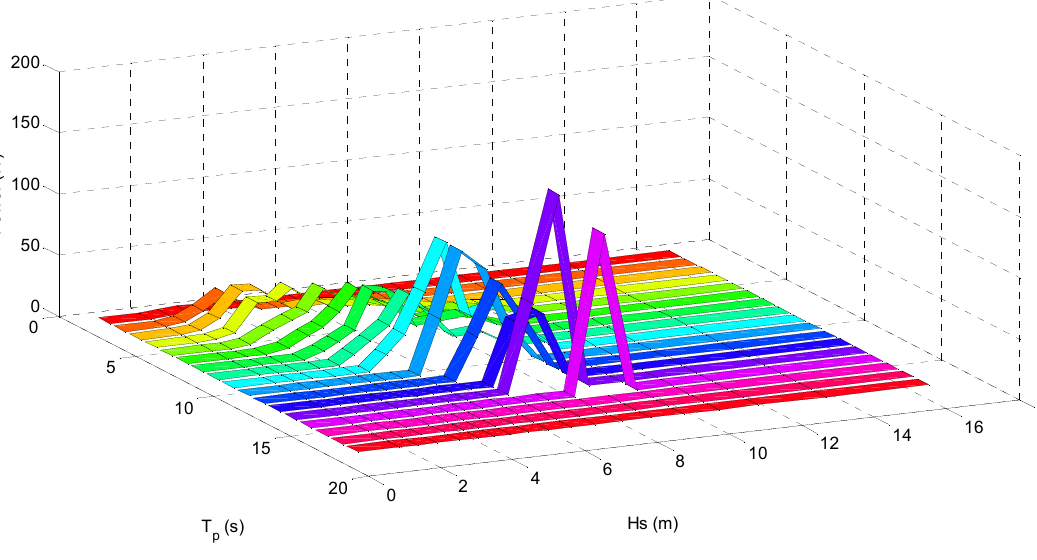
Figure 24. Average wave energy flux for different classes of T